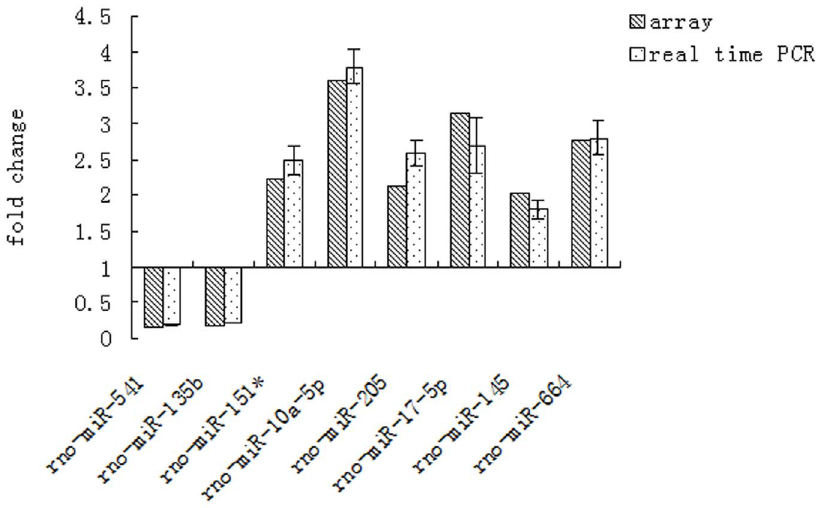
Figure 5. Differential miRNAs expression in gene array and Q-PCR.